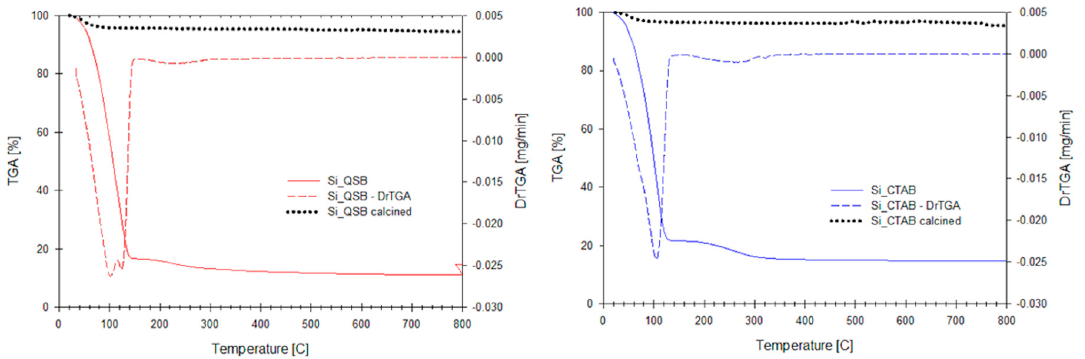
Figure 6. TG profile of SiNC_CTAB and SiNC_QSB2-12.